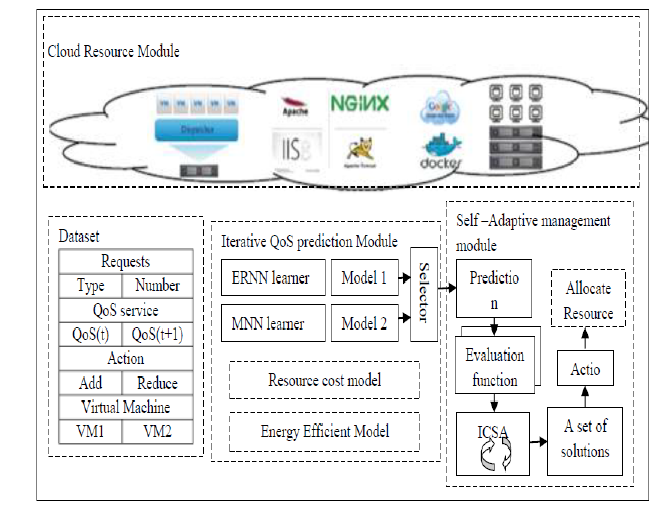
Figure 2. The comprehensive process of the novel self-adaptive resource allocation technique.